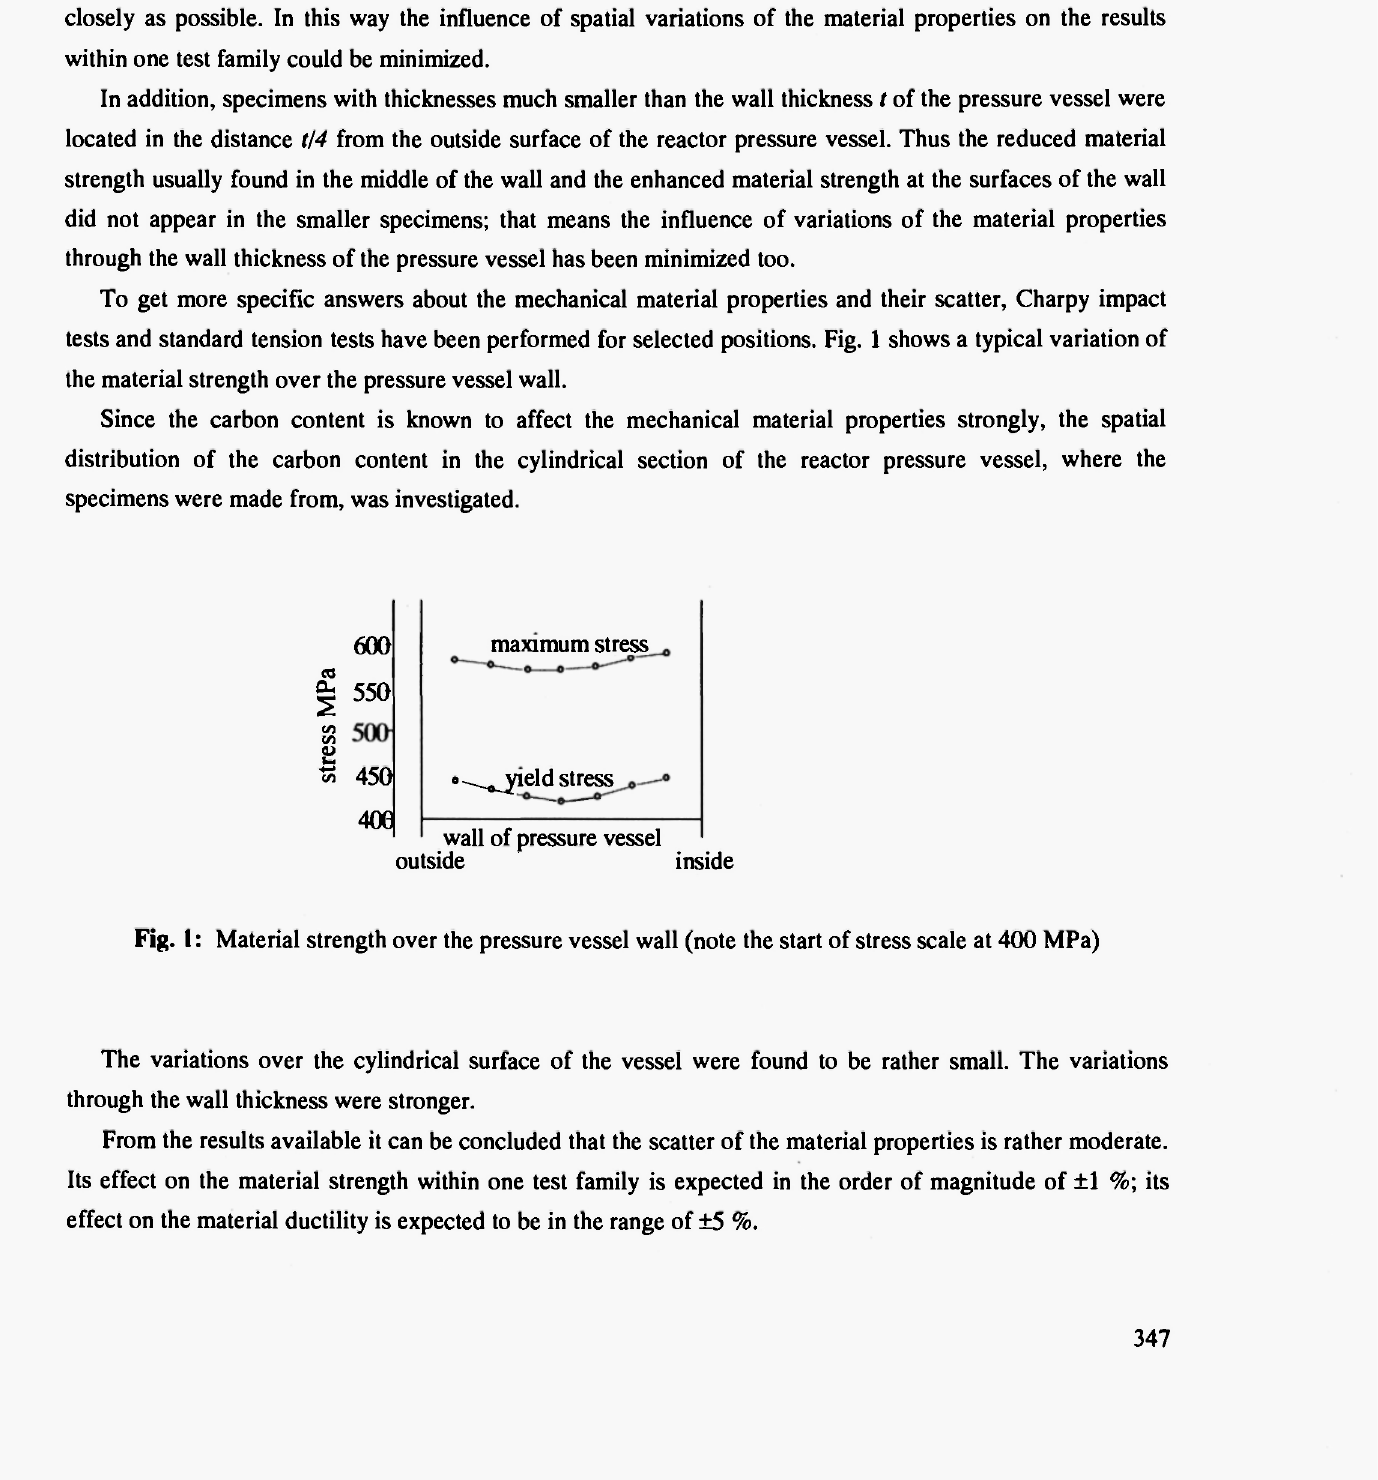
Fig. 1 : Material strength over the pressure vessel wall (note the start of stress scale at 400 MPa)